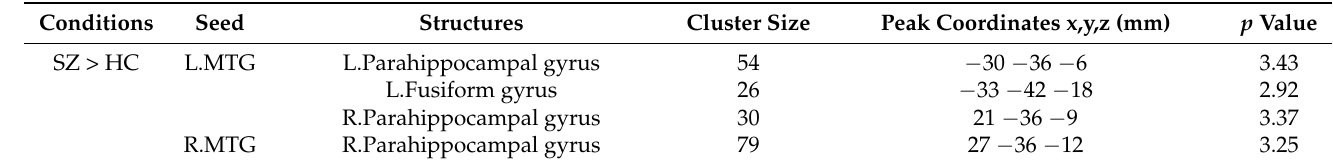
Table 2. Psychophysiological interaction analysis at the condition of ToM > random (AlphaSim corrected p <